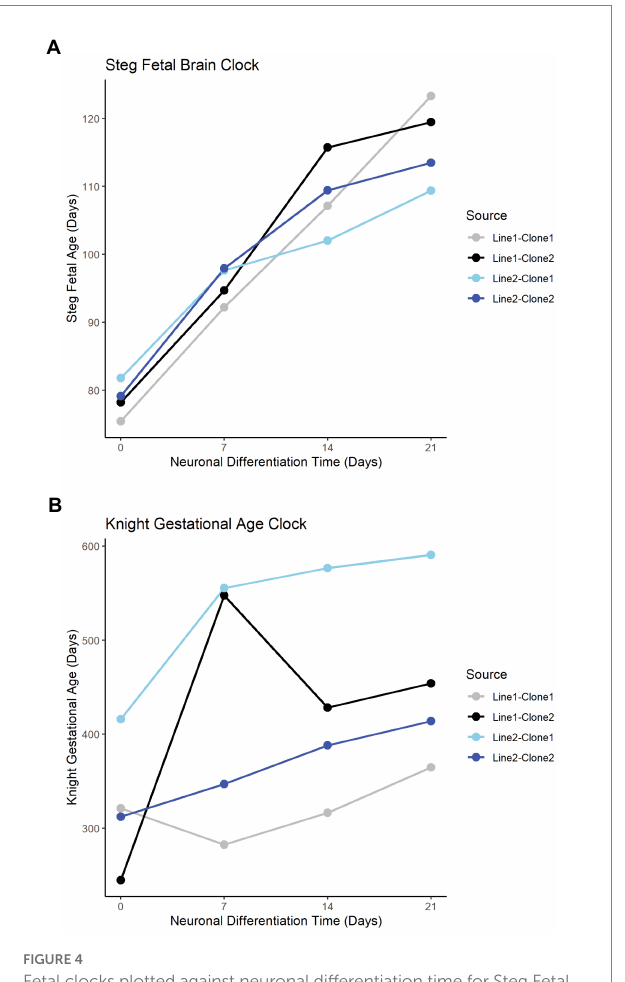
FIGURE 4 Fetal clocks plotted against neuronal differentiation time for Steg Fetal Brain Clock (A) , and Knight Gestational Age Clock (B) . NPCs noted as time = 0. Color of plot line indicates cell line and clone source.